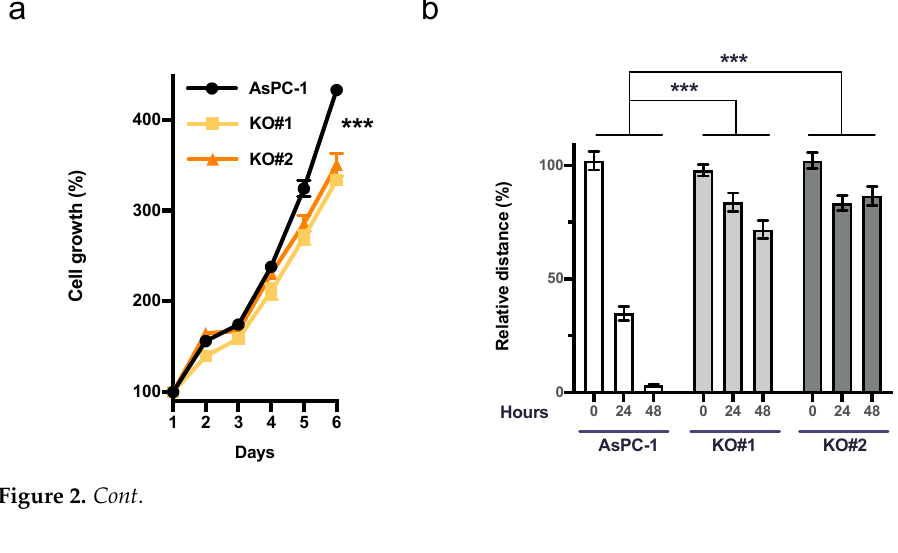
Figure 2. Decreased cell growth, motility, and response to gemcitabine of AsPC uPAR knockout clones. ( a ) Cell growth analysis (6 days) of uPAR -/- clones with a significantly slower proliferation rate than WT controls ( n = 3). ( b ) Reduced migratory capacity of AsPC-1 uPAR -/- clones compared to uPAR WT cells ( n = 3). ( c ) Western blot analysis of 9 epithelial and mesenchymal markers in PANC- 1, AsPC-1, and uPAR -/- clones indicated mesenchymal to epithelial transition (MET) in uPAR -/- cells. Uncropped Western blot images available in Supplementary Material File S1 ( d ) Increased re- sistance of uPAR -/- clones to gemcitabine treatment (0.1, 0.5 and 1 µM) for 72 h ( n = 4 biological replicates). (KO#1 and KO#2, uPAR -/- clones) (*** p < 0.001). Western blot revealed a marked upregulation of epithelial markers E-cadherin and β -catenin. While the transcription factor Slug was slightly upregulated, Snail and TCF8/ZEB1, together with claudin and ZO1, showed a decreased expression, further in- dicating the mesenchymal to epithelial transition (MET) in uPAR -/- clones compared to AsPC-1 WT (Figure 2c). In accordance with this phenotype, we detected a marked increase in chemoresistance against up to 1 µM gemcitabine in uPAR -/- cells (Figure 2d). 3.4. Depletion of uPAR Activates FAK, CDC42, and p38 and Induces Autophagy uPAR signaling has been described to involve FAK, Src, CDC42, p38, autophagy, and RAS signaling [32]. In addition, Wu et al. reported that FAK signaling contributes to in- trinsic gemcitabine chemoresistance in pancreatic cancer cell lines [33]. By immunoblot- ting, we detected the activation of FAK, CDC42, p38, and LC3B, while ERK was inacti- vated in AsPC-1 uPAR -/- cells (Figure 3a). The influence of FAK on Ras signaling has been described before [34]. However, in cells with aberrant KRAS activation, FAK-Ras regula- tion seems to be disturbed.